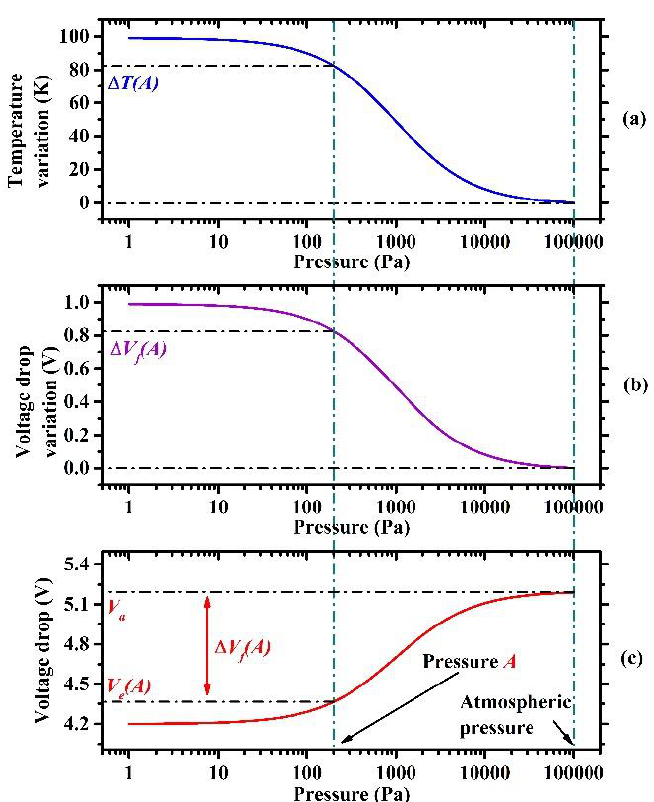
Figure 2. ( a ) Temperature variation of a micro-hotplate (MHP) rises with the decrease in vacuum pressure because of the reduced gaseous heat loss, ( b ) voltage drop variation of six series diodes rises with temperature variation, ( c ) voltage drop across six series diodes falls with decreasing vacuum pressure as a result of the negative temperature coefficient of diode.